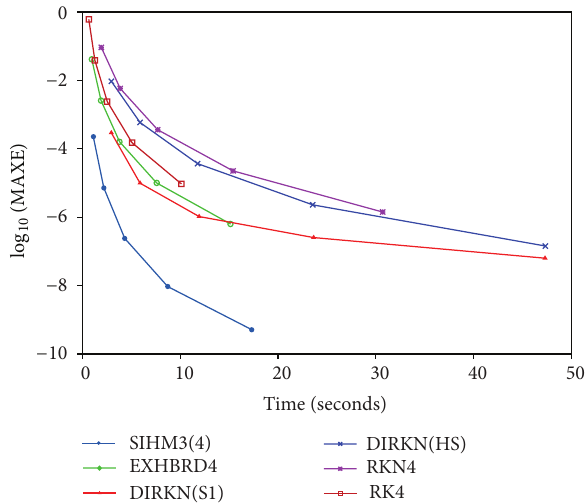
Figure 7: The efficiency curves for SIHM3 (4) method for Inhomo- geneous problem with ℎ = 0.125/2 𝑖 , 𝑖 = 2,...,6 .